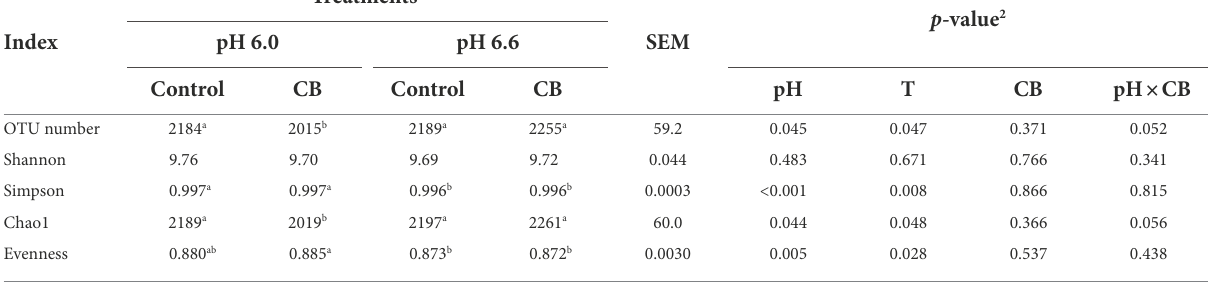
TABLE 3 Bacterial alpha diversity indexes of fermentation fluid supplemented with CB at low or high media pH after 24 h of in vitro